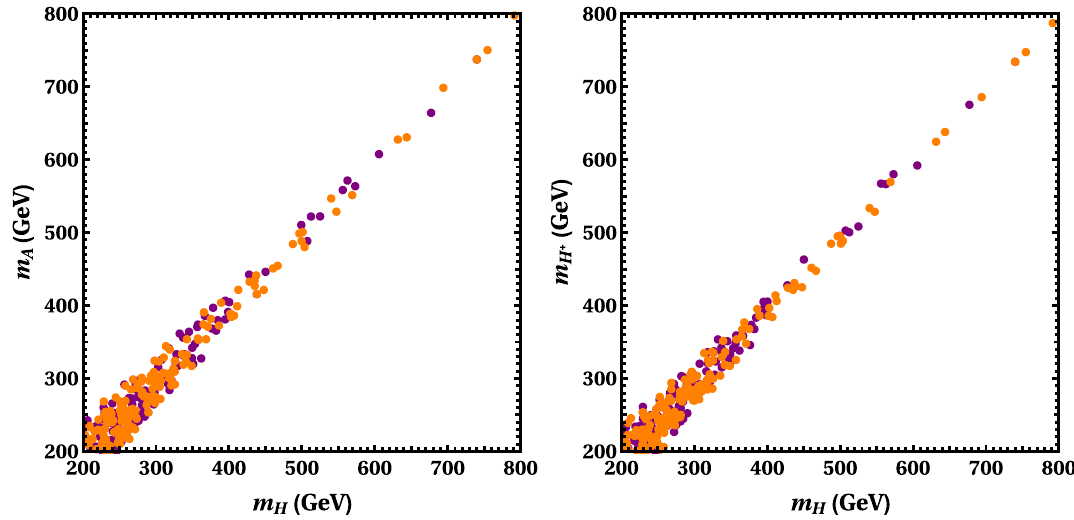
Fig. 3 The scanned points corresponding to Fig. 1 that are traced back and plotted in the m A – m H and m H ± – m H planes for y = 0 in Scenario-I